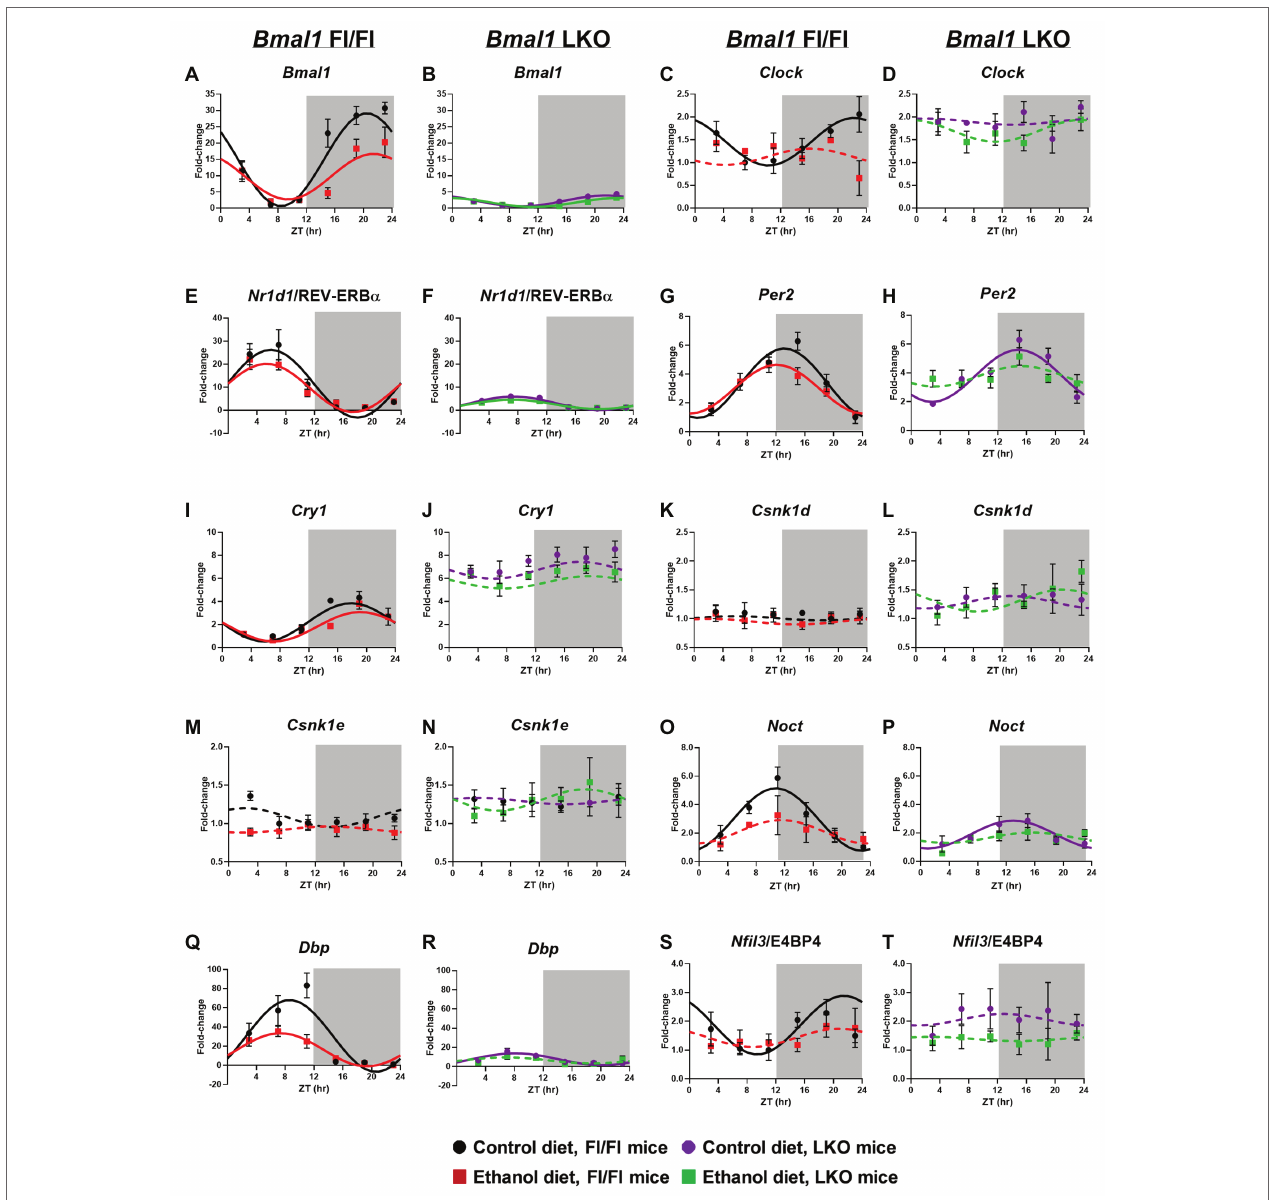
FIGURE 1 | Chronic alcohol and liver clock disruption alter 24 h mRNA rhythms in molecular clock genes in the liver. Diurnal mRNA profiles of Brain and Muscle ARNT-like 1 ( Bmal1 ; A,B ), Circadian Locomotor Output Cycles Kaput ( Clock ; C,D ), Nuclear Receptor Subfamily 1 Group D Member 1 ( Nr1d1 /Rev-Erb α ; E,F ), Period 2 ( Per2 ; G,H ), Cryptochrome 1 ( Cry1 ; I,J ), Casein Kinase 1 Delta ( Csnk1d ; K,L ), Casein Kinase 1 Epsilon ( Csnk1e ; M,N ), Nocturnin ( Noct ; O,P ), D site of Albumin Promoter Binding Protein ( Dbp ; Q,R ) and Nuclear Factor, Interleukin 3 Regulated ( Nfil3 /E4BP4; S,T ) were measured in livers of control-fed (black) and alcohol-fed (red) Bmal1 Flox/Flox (Fl/Fl) and control-fed (purple) and alcohol-fed (green) Bmal1 liver-specific knockout (LKO) mice at ZT 3, 7, 11, 15, 19, and 23 (ZT 0: lights on/ inactive period, ZT 12: lights off/active period, gray area) by real time (RT)-PCR. Data are presented as a fold-change to the Bmal1 Fl/Fl control diet trough time-point and normalized to Gapdh . Cosinor analysis was performed using a nonlinear regression module in SPSS. Data are expressed as mean ± SEM for n = 4–8 mice/ genotype/diet/time-point. Solid lines indicate rhythmic mRNA levels and a significant cosine fit, whereas dashed lines indicate arrhythmicity and a non-significant cosine fit. Results for Cosinor and ANOVA analyses are provided in Supplementary Tables 1 and 2 , respectively.